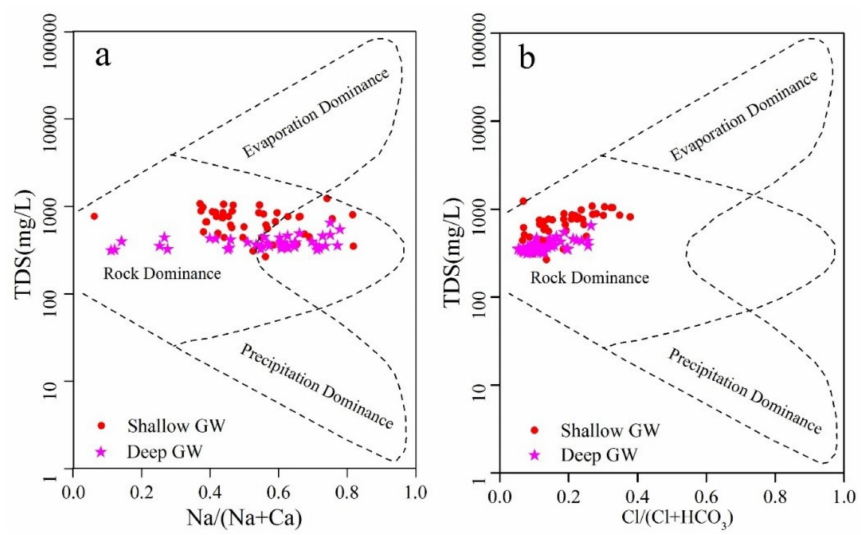
Figure 4. Gibbs diagrams showing the mechanism of groundwater evolution. ( a ) TDS vs. Na + /(Na + + Ca 2+ ); ( b ) TDS vs. Cl − /(Cl − + HCO 3 −